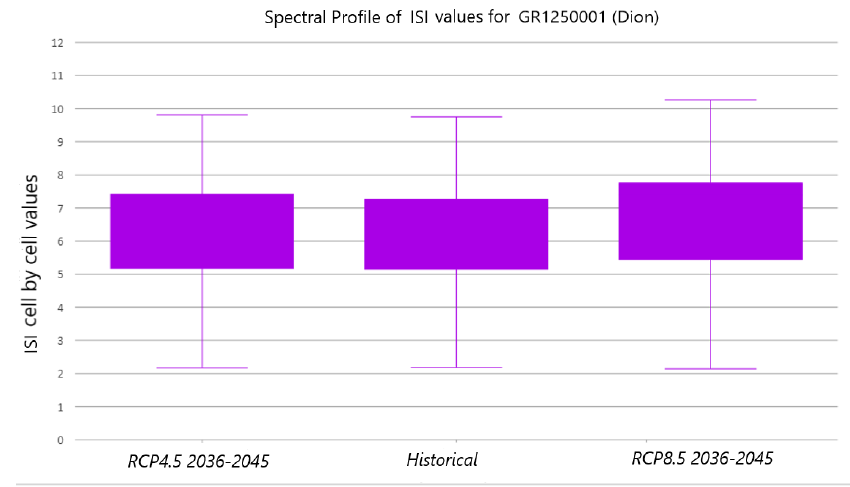
Figure 10. Spectral Profile of Initial Spread Index (ISI) values for GR2410002 (Delphoi), for RCP 4.5 2036–2045 ( left ), historic period ( centre ), and RCP 8.5 2036–2045 ( right ).